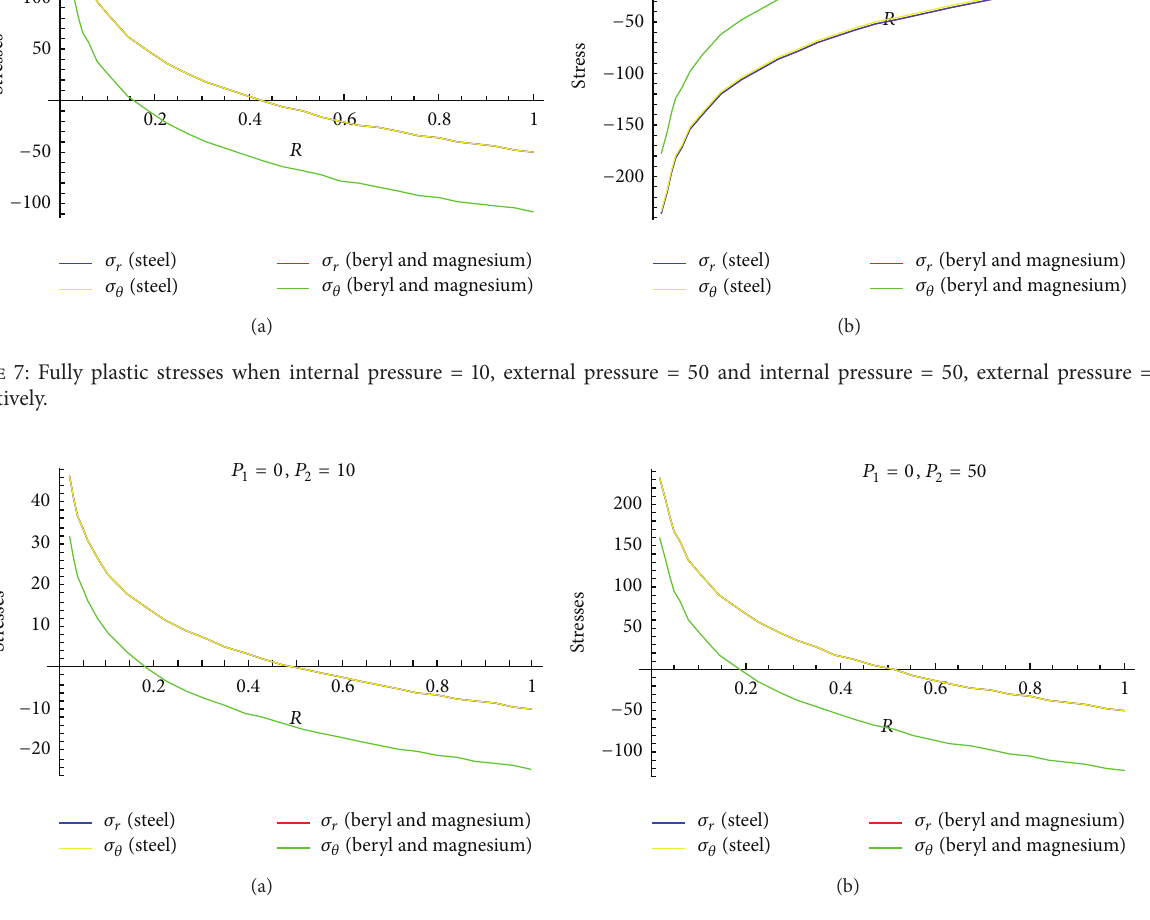
Figure 8: Fully plastic stresses when external pressure 𝑃 2 = 10 and external pressure 𝑃 2 = 50 (without internal